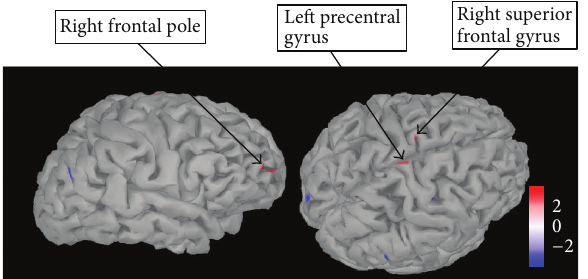
Figure 4: Regions showing significantly higher activation in the AN-C compared to HC group at 150 ms after stimulus. The figure shows the regions showing significantly higher activation in a 𝑡 - test comparing the AN-C and HC group (shown in red) at 150ms after stimulus (all food pictures versus baseline). Regions were identified by eye and are uncorrected for multiple comparisons ( 𝑝 = 0.005 ). Scale shown represents the 𝑡 -value. AN-C: current Anorexia Nervosa group, HC: healthy control group.